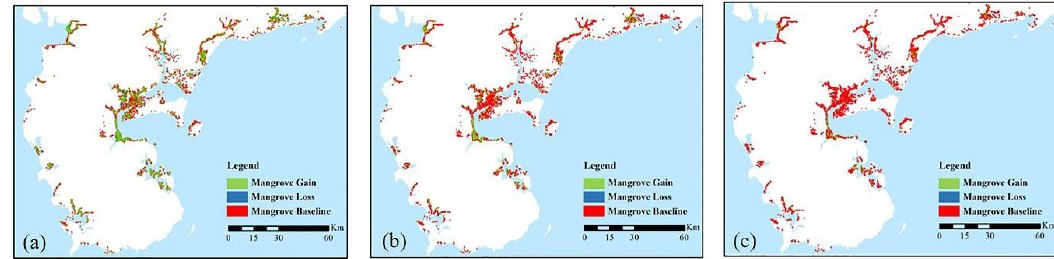
Figure 8. Mangrove distribution changes in the southern part of Guangdong province after the 1990s: